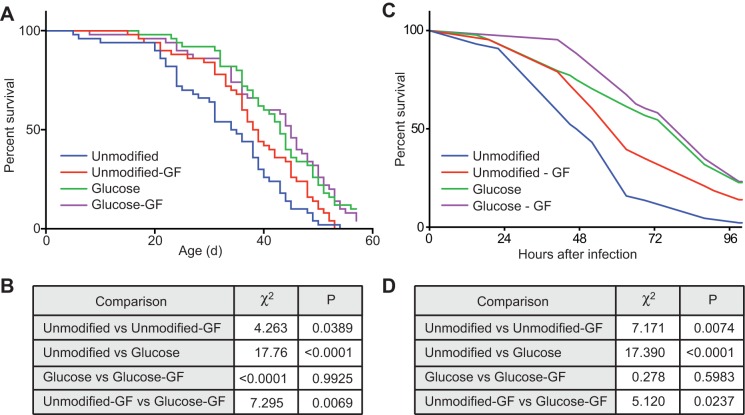
Glucose improves longevity and immunity independent of the microbiota. (A) Survival curves of males fed a holidic diet with or without glucose and raised under conventional or germ-free (GF) conditions. (B) Results of Log-rank (Mantel–Cox) test of data in panel A. (C) Survival curves of chronically infected female flies fed a holidic diet with or without glucose and raised under conventional or germ-free (GF) conditions. (D) Results of Log-rank (Mantel–Cox) test of data in panel C.